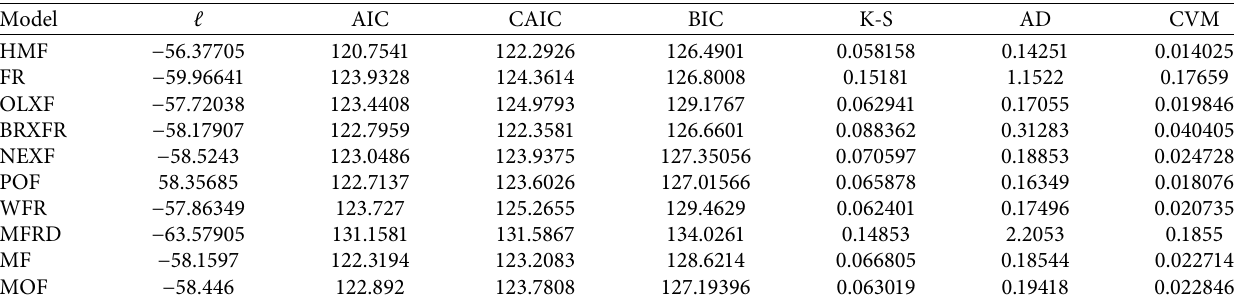
Table 11: Log-likelihood and comparison criteria for Ghana unemployment rate